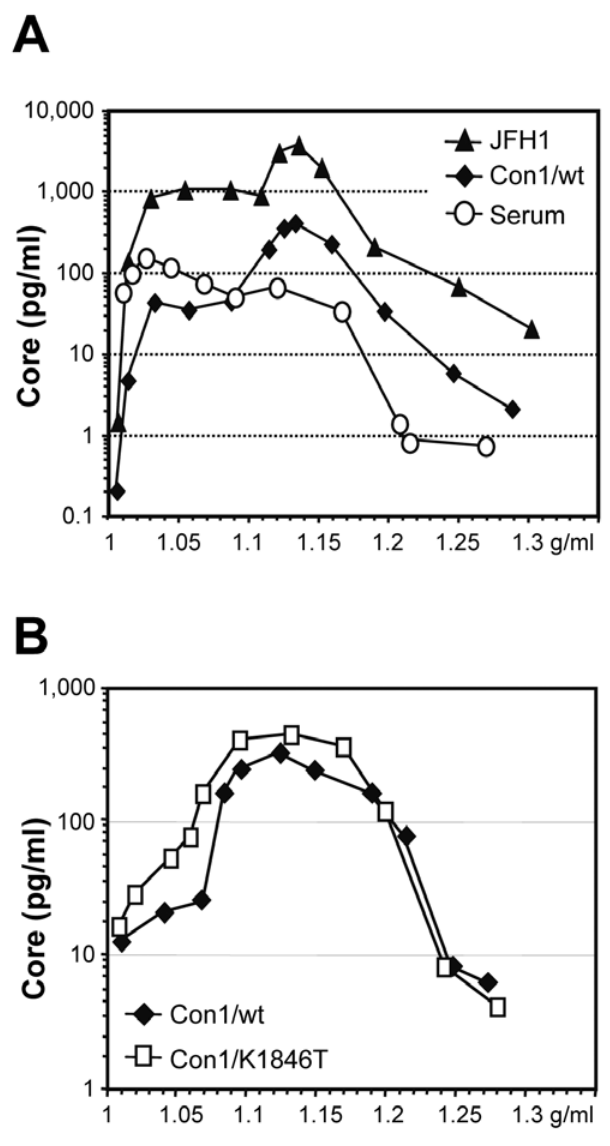
Figure 5. Density profiles of HCV particles derived from Con1/ wt, Con1/K1846T, JFH-1 and patient serum. (A) Approximately 22 ml of filtered cell culture fluid harvested 24 h after transfection of Huh-7 cells with Con1/wt RNA were concentrated via ultracentrifuga- tion over a 60% iodixanol cushion. In case of JFH-1 approximately 26 ml supernatant harvested 96 h post transfection and concentrated in the same manner were used. The concentrates were overlaid with a linear iodixanol gradient (0%–60%) and spun for 20 h at 110,000 g at 4 u C. In a similar experiment, 0.5 ml of high titer patient serum was resolved in an iodixanol density gradient. Twelve fractions a` 1ml were harvested from the top, and the amount of HCV core protein contained in each fraction was determined by Trak C ELISA, respectively. HCV core content per fraction is plotted against the density of the respective fraction. (B) Result of an analogous experiment but using culture supernatant of Huh-7 cells after transfection with Con1/wt or Con1/K1846T. lipoproteins. Interestingly, cell culture-derived Con1/wt and JFH- 1 particles exhibited an analogous density profile but with very different ratios when compared to the patient-derived particles. Most particles had a density of 1.14 g/ml, whereas only a minor and broad peak was found at very low density in the range of 1.03